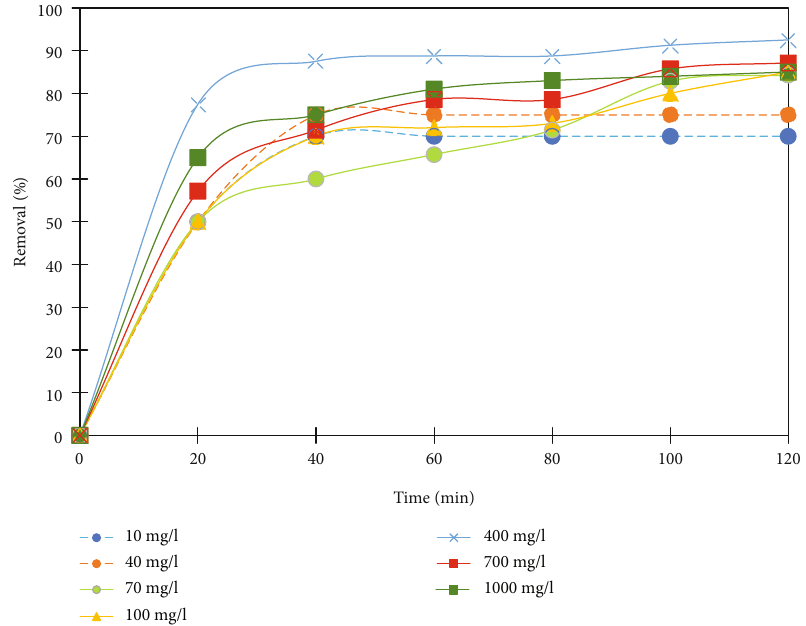
Figure 4: Removal e ffi ciency of phenol at various initial concentrations at dose = 0 : 5 g , pH = 6 , contact time = 2h , and stirring speed = 200rpm